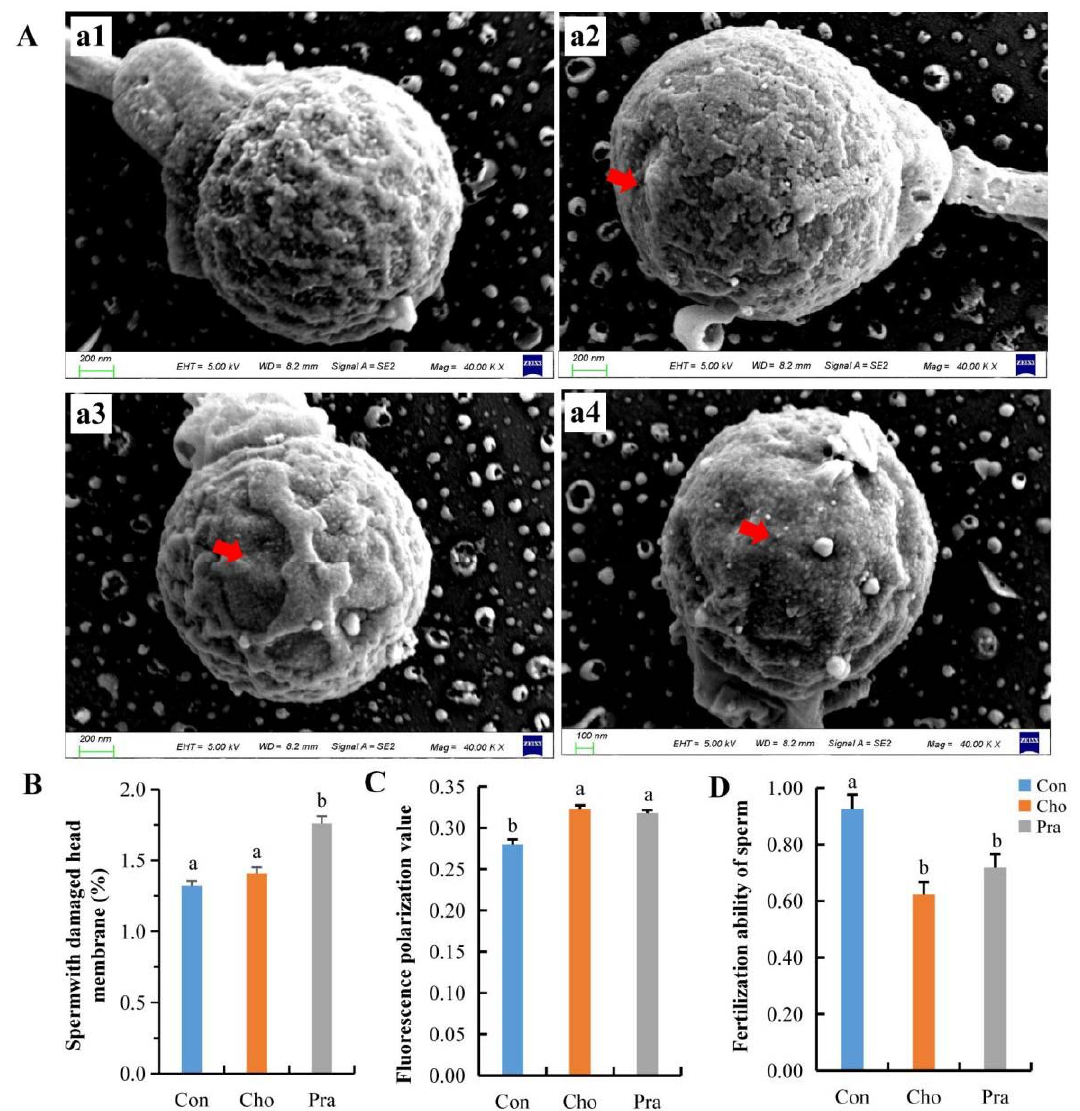
Figure 5. Changes in sperm cell membrane and insemination capacity; ( A ) SEM image of sperm head, a1: normal sperm from Con group, a2: cell membrane defect sperm in Cho group, a3 and a4: cell membrane defect sperm in Pra group, red arrows indicate damaged sperm head membrane; ( B ) cell membrane breakage rate of sperm head; ( C ) fluidity of cell membrane; ( D ) fertilization ability of sperm. All statistical data were expressed as mean ± SD. There is a significant difference between the two groups without the same letter at p < 0.05 level.